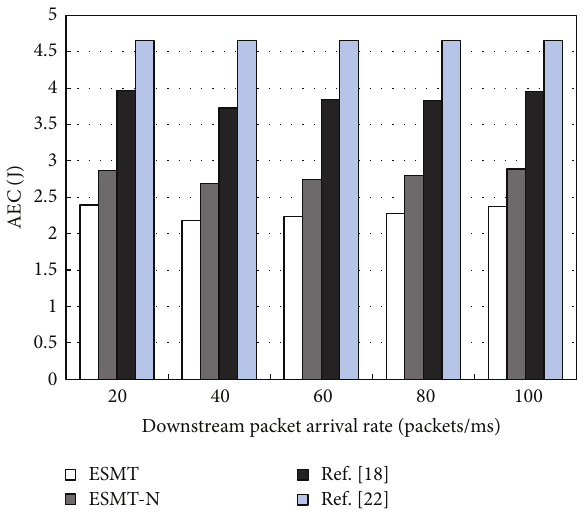
Figure9:ComparisonofAEC,givenanupstreampacketarrivalrate of 10